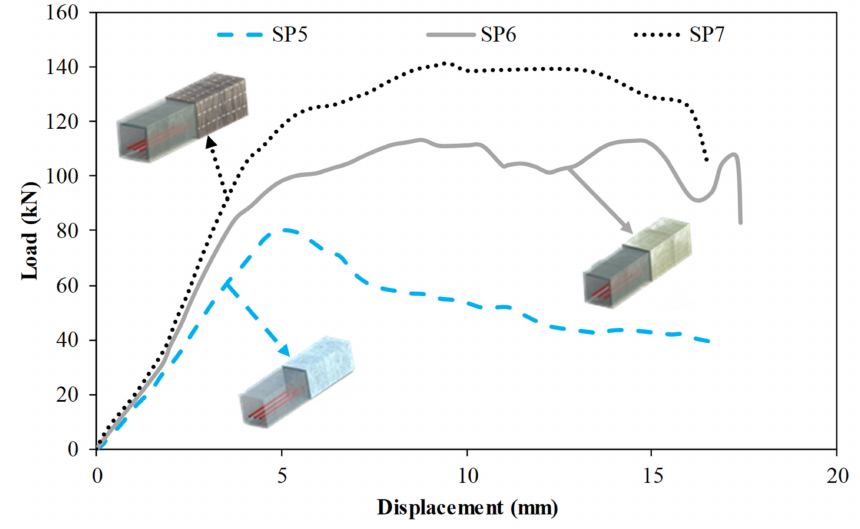
Figure 9. Comparison of specimens SP5, SP6 and